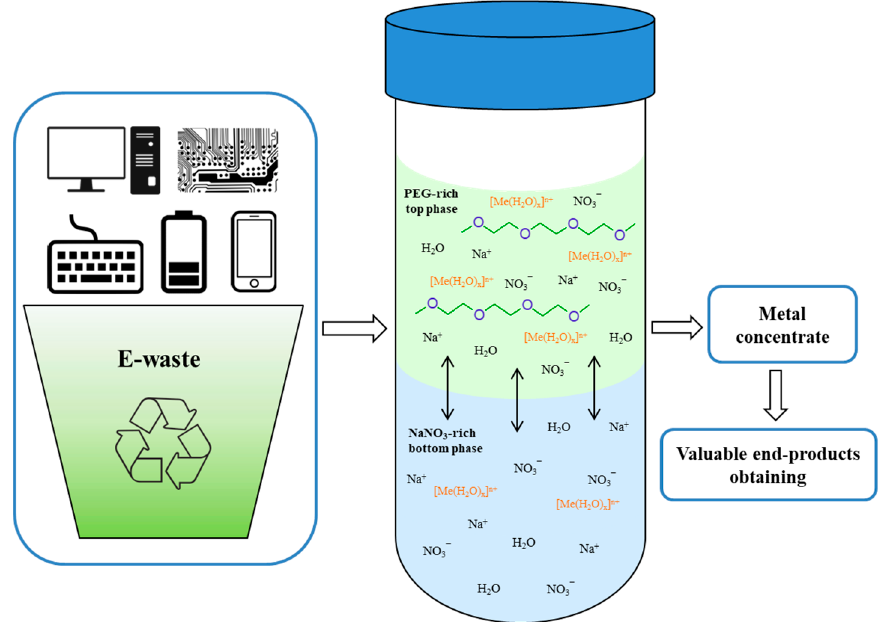
Figure 6. Scheme of the complex extraction of metal ions in the PEO 1500-NaNO 3 -H 2 O system and the possibility of its practical application.